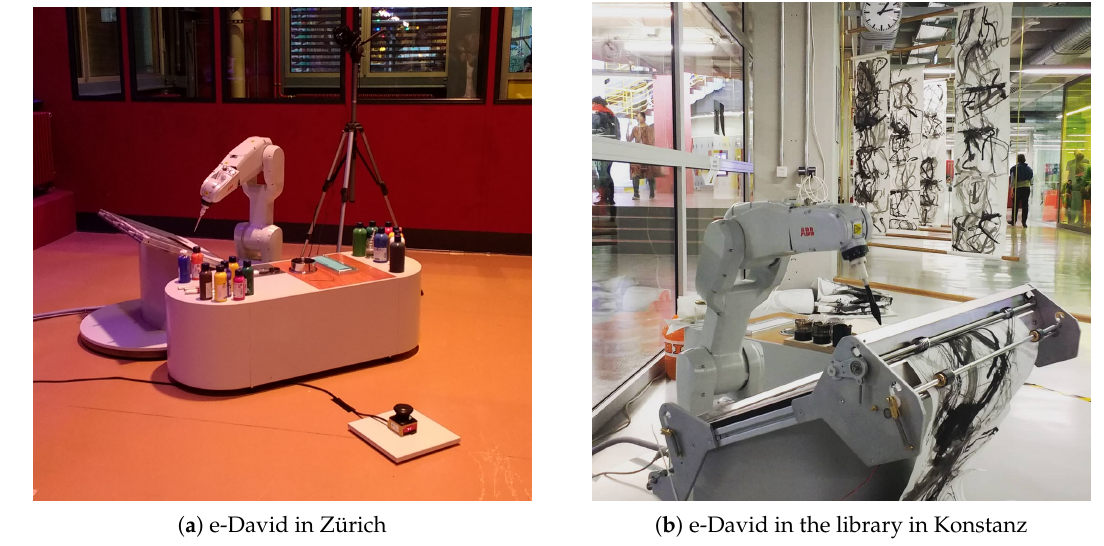
Figure 7. e-David on